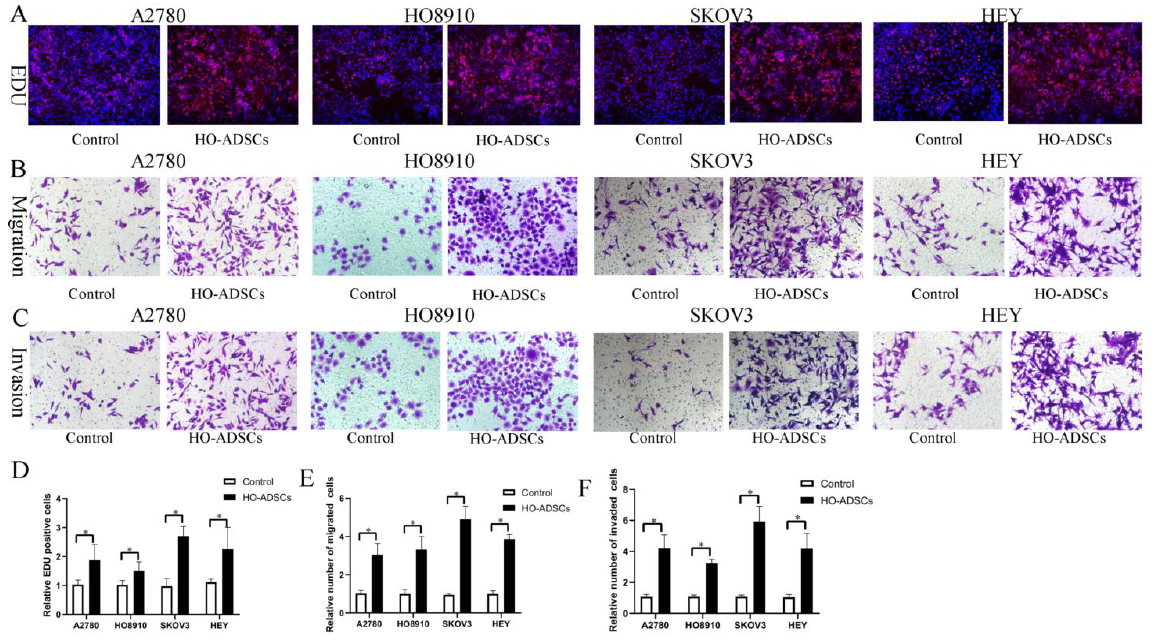
Figure 2. HO-ADSCs promote human EOC cell proliferation, migration, and invasion (A2780, HO8910, SKOV3, and HEY) in vitro. ( A ). The influence of HO-ADSC on human EOC cell proliferation was measured by EdU assay. ( B ). The influence of HO-ADSC on human EOC cell migration was measured by Transwell assay. ( C ). The influence of HO-ADSC on human EOC cell invasion was measured by Transwell assay. ( D ). Quantification of proliferation rates showed that the proliferative capacity of human EOC cell lines was significantly improved when cocultured with HO-ADSCs. ( E ). Quantification of the migrating cells showed that the migratory capacity of human EOC cell lines was significantly improved when cocultured with HO-ADSCs. ( F ). Quantification of the invasion rates of human EOC cell lines showed that the invasive capacity of human EOC cell lines was significantly improved when cocultured with HO-ADSCs. * p < 0.05, n = 3.